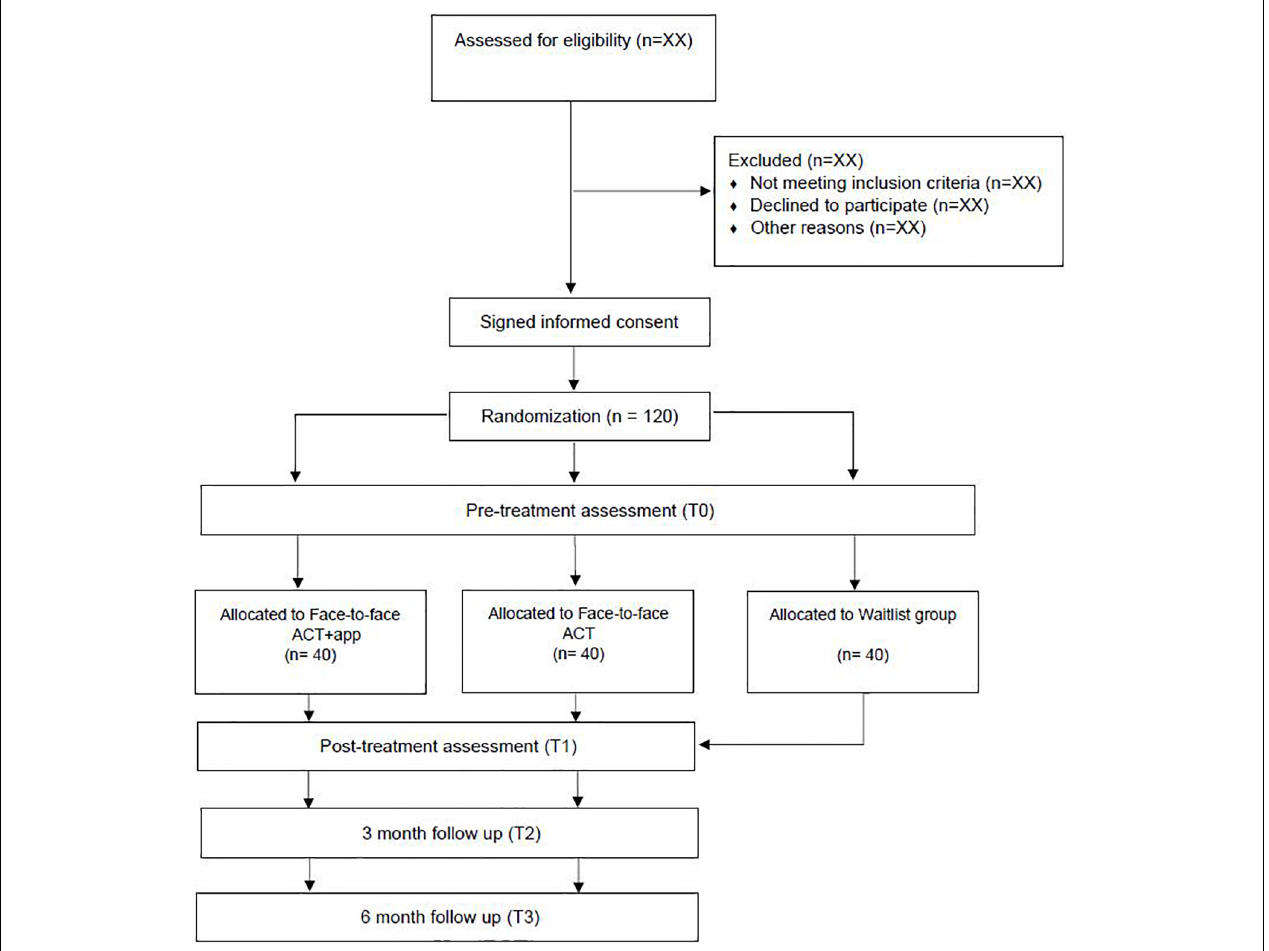
FIGURE 1 | Study protocol